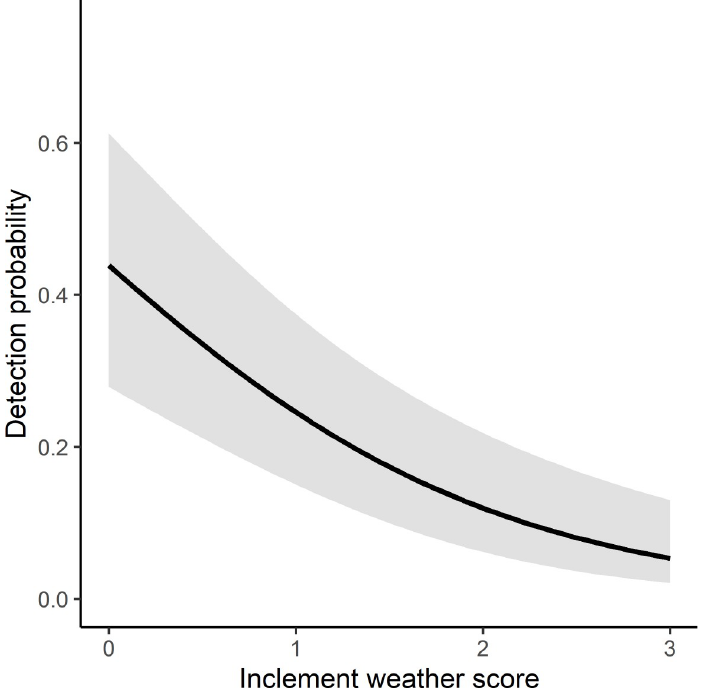
Fig 4. Influence of the inclement weather score on detection probability of Yellow-bellied Gliders ( Petaurus australis ). The score ranged from 0 (inclement weather score = 0) to 3 (inclement weather score = 3). 95% confidence intervals are shaded grey.